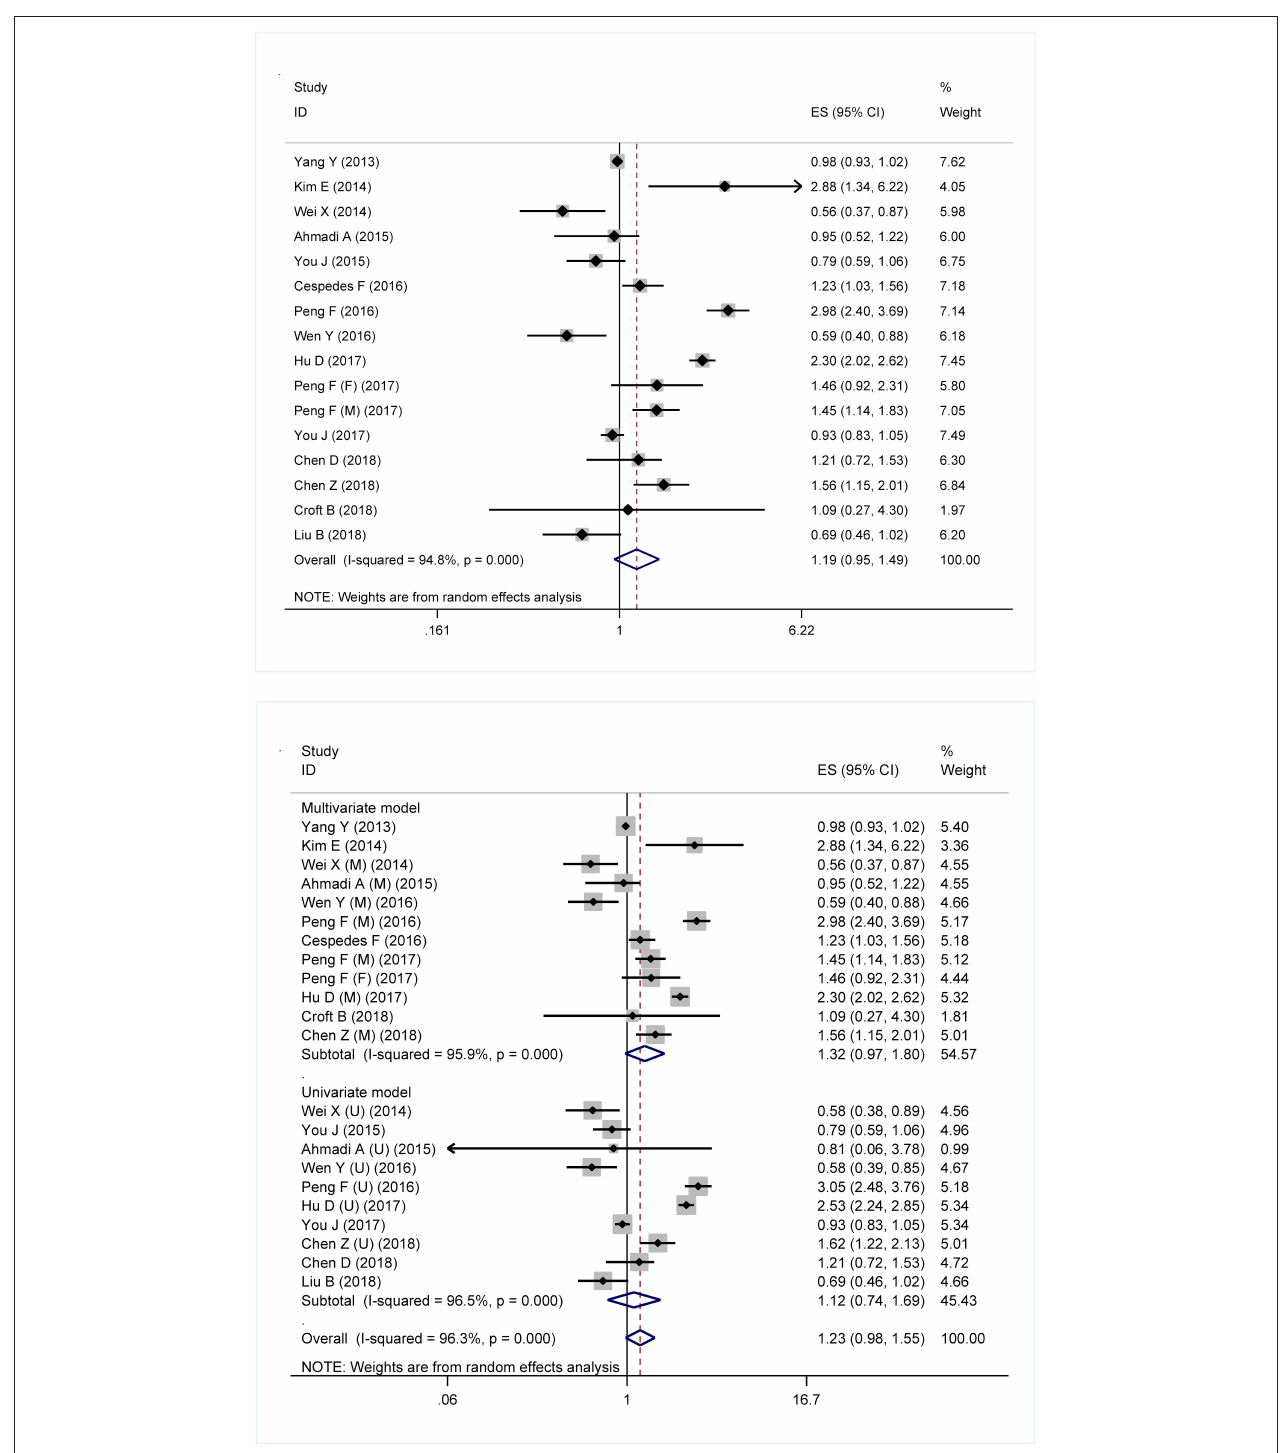
FIGURE 1 | Forest plots for the prediction of metabolic syndrome for the survival of digestive tract cancer overall (Upper) and under different models (Lower) . ES, effect size; 95% CI, 95% confidence interval.